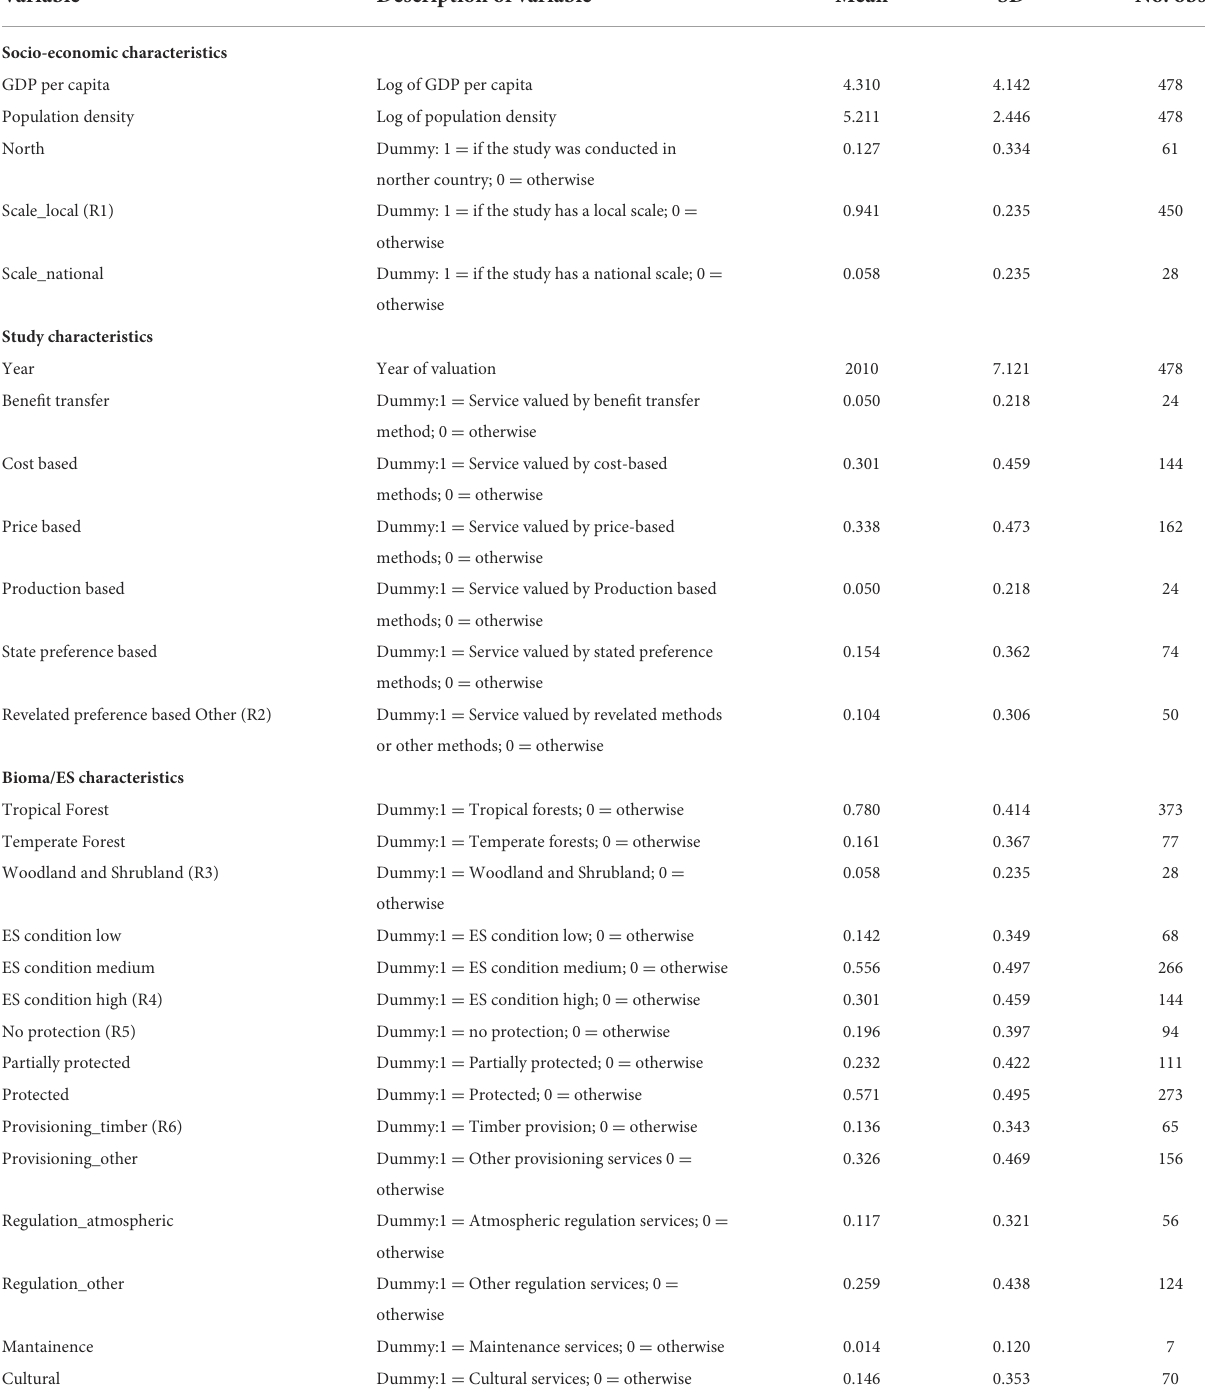
TABLE 1 Variables included in the